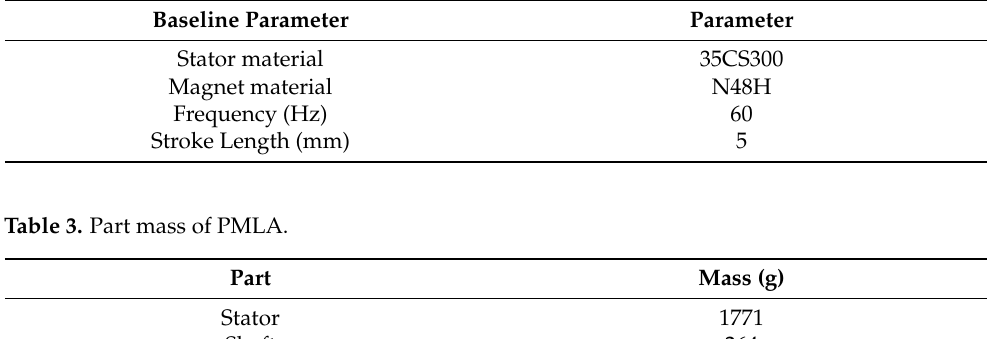
Table 2. Baseline case parameters.